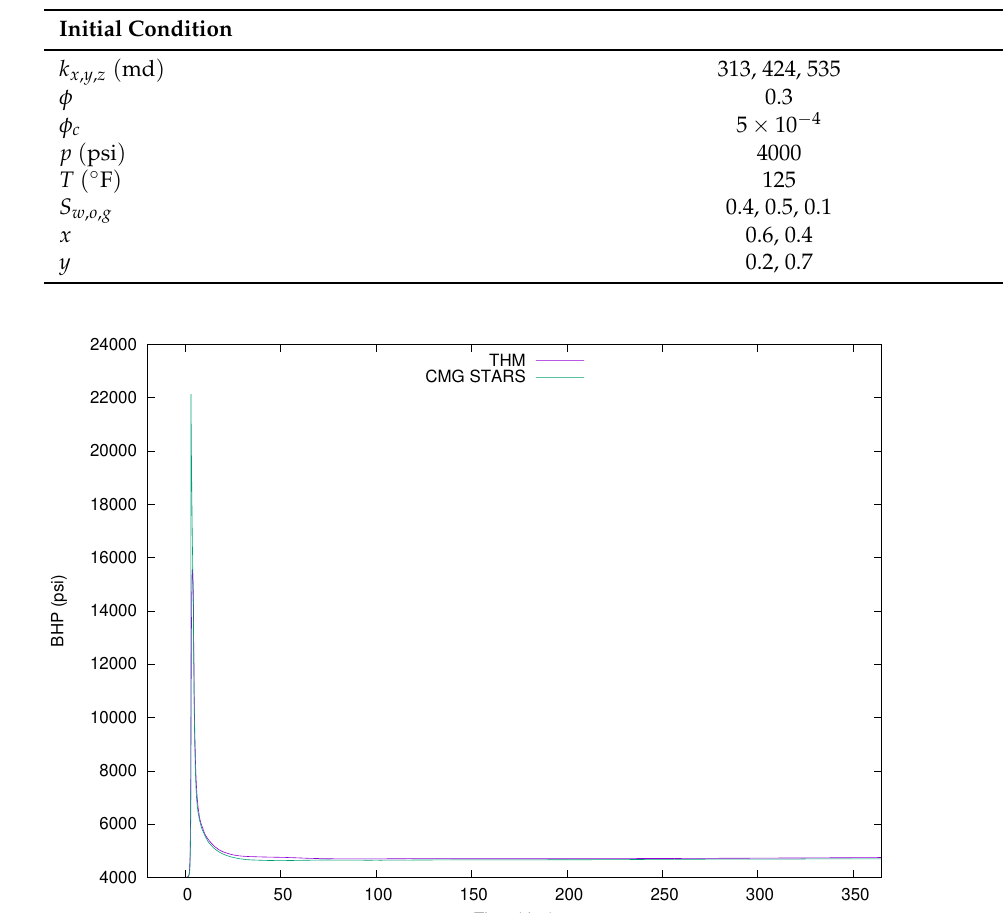
Table 9. Initial data for Example 2.